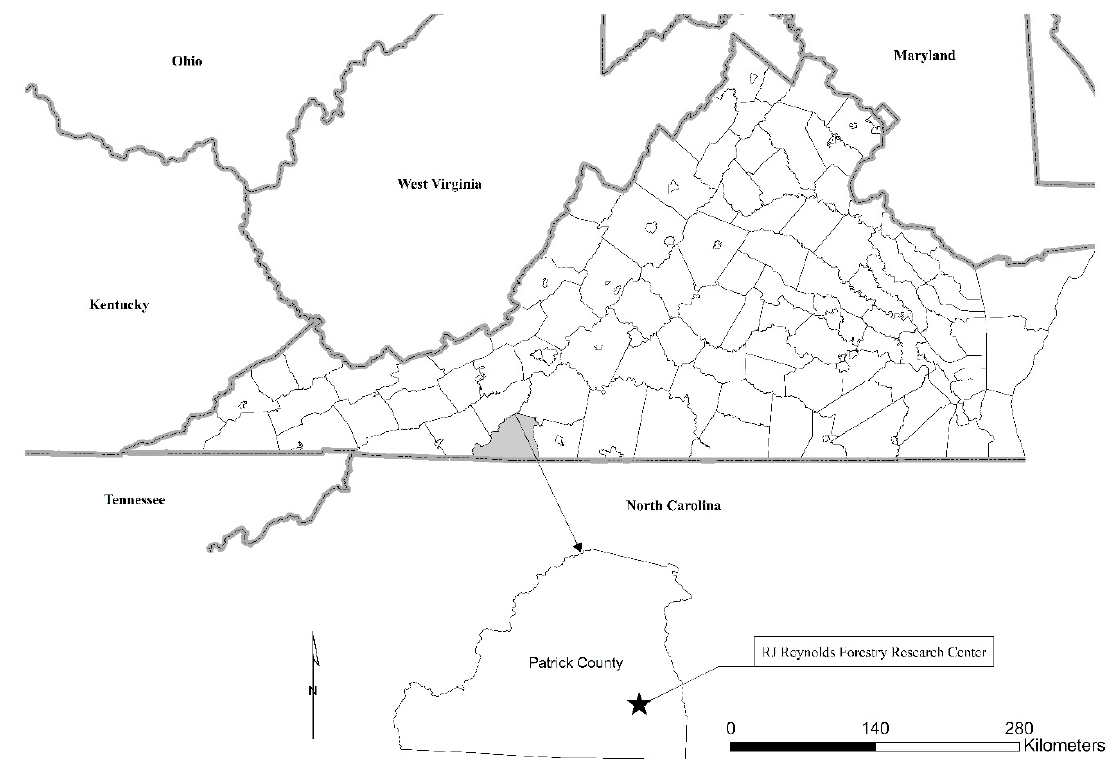
Figure 1. Location of the Reynolds Forestry Research Extension Center, Critz, Virginia.